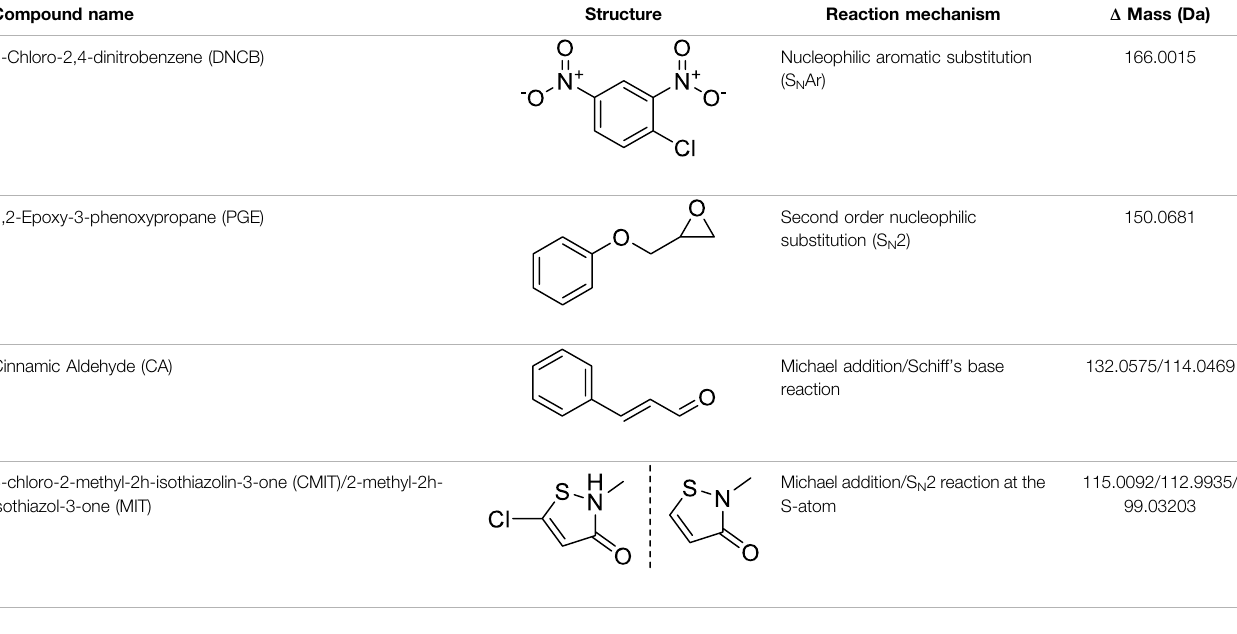
TABLE 3 | Name and structure of hapten, reaction mechanism, and expected Δ Mass in Da following haptenation.